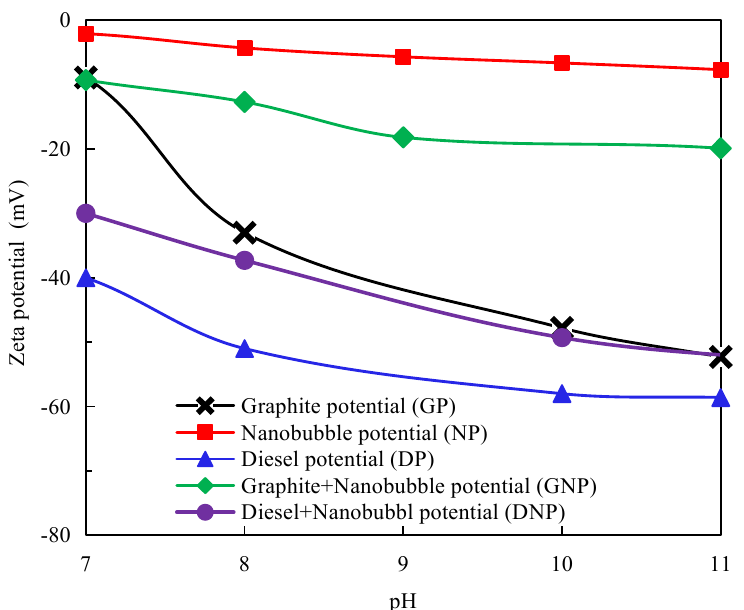
Figure 7. Surface potential of PMFG, nanobubbles, graphite + nanobubbles, diesel, and diesel + nanobubbles.